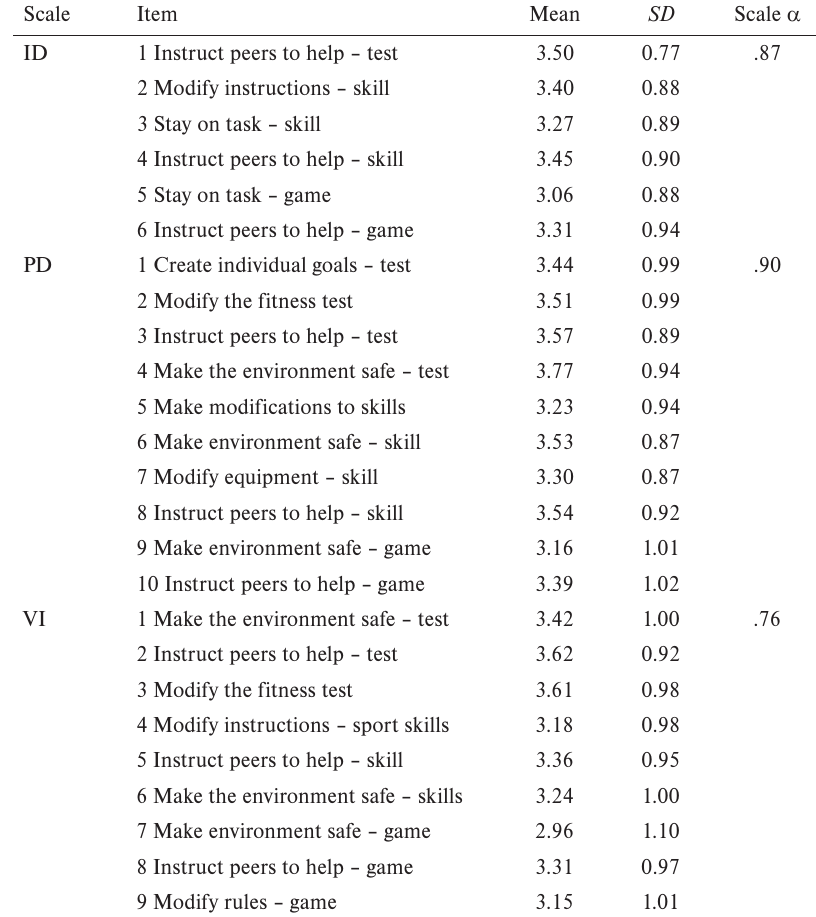
Descriptive statistics of scale items and Cronbach’s reliability (N = 252)